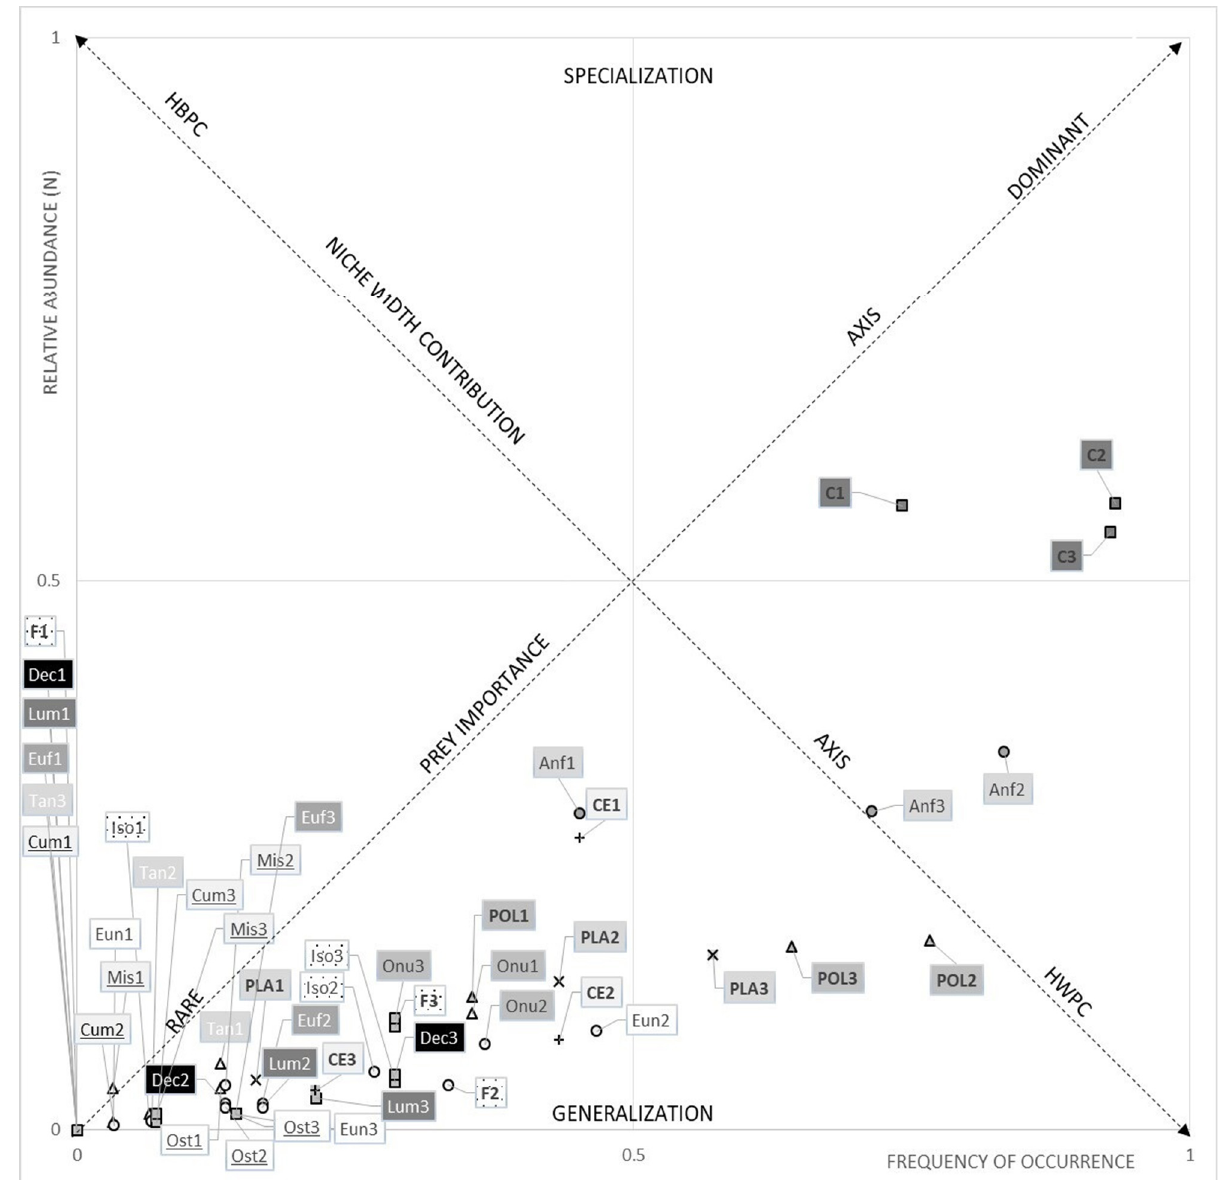
Figure 3. Costello’s diagram applied to prey composition found in the stomachs of a sample of the hollow-snout grenadier Caelorinchus coelorhincus from the bathyal plane of the central Tyrrhenian Sea 1, 2 and 3 inside the data labels represent small, intermediate and large size classes and same labels ‘background denotes same prey category. C: total crustaceans, dark grey squares; POL: total polychaetes, dark grey triangles; F: bony fishes, light grey circles; CE: cephalopods; crosses; MP: microplastics, asterisks; Dec: Decapoa; light grey squares; Euf: Euphasiacea, intermediate grey circles; Tan: Tanaidacea, white triangles; Ost: Ostracoda, intermediate grey squares; Anf: Anfipoda, dark grey circles; Mis: Misydacea, withe circles; Iso: Isopoda, very light grey circles; Cum: Cumacea, white diamonds; Onu: Onuphidae, light grey circles; Eun: Eunicidae, light grey circles; Lum: Lumbrinereidae, dark grey squares.